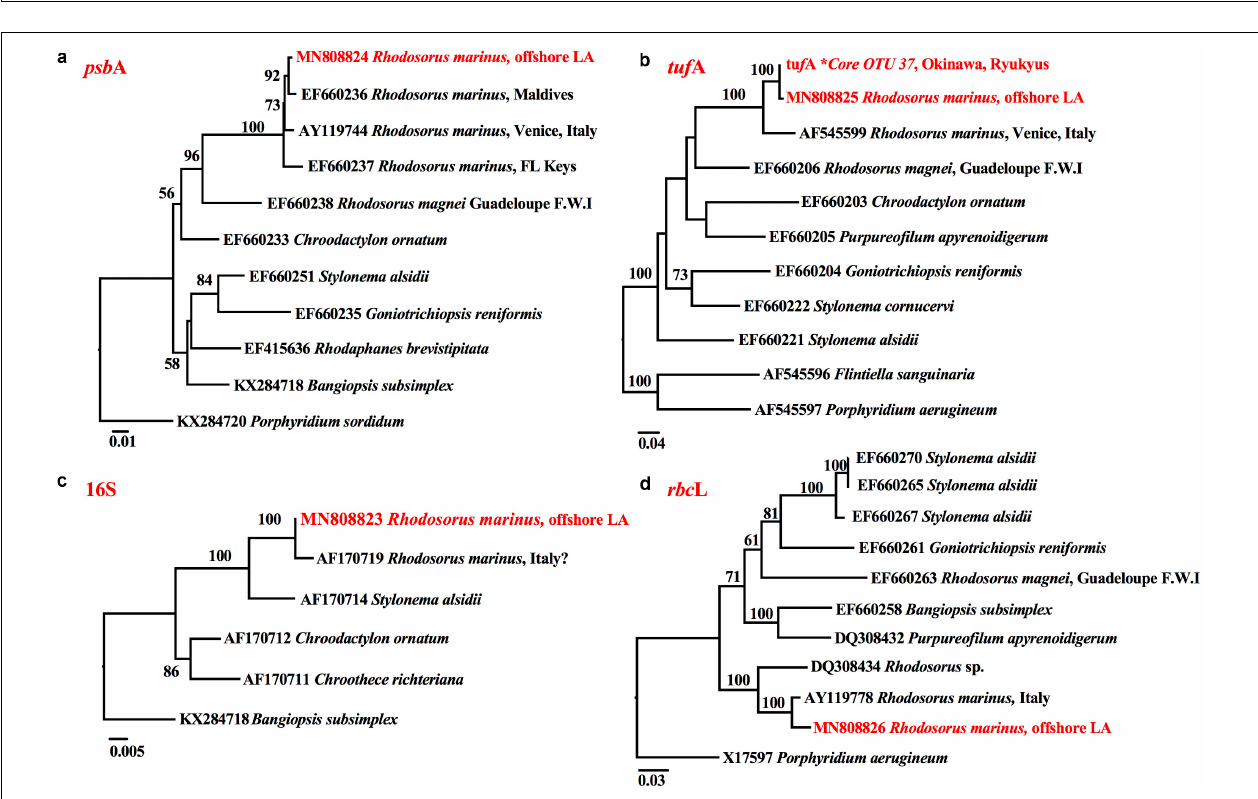
FIGURE 4 | RaxML phylograms of (a) psb A, (b) tuf A, (c) 16S, and (d) rbc L sequences showing that the endolithic Rhodosorus species from offshore Louisiana (highlighted in red) corresponds to the R. marinus from (a) the Maldives, Venice, Italy, and the Florida Keys, (b) Venice, Italy, and a Core OTU * from Okinawa, Ryukyus, Japan, (c) Italy? (SAG.116.79), and (d)